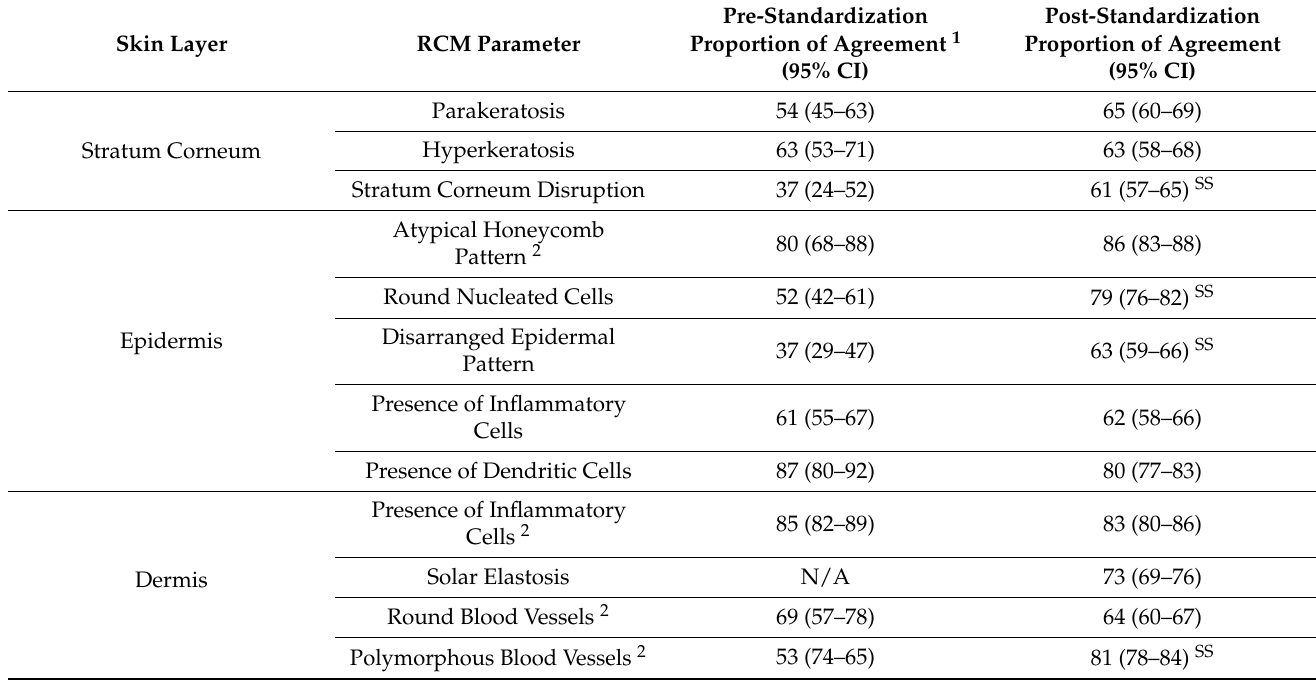
Table 2. Interobserver agreement of RCM parameters for AK.